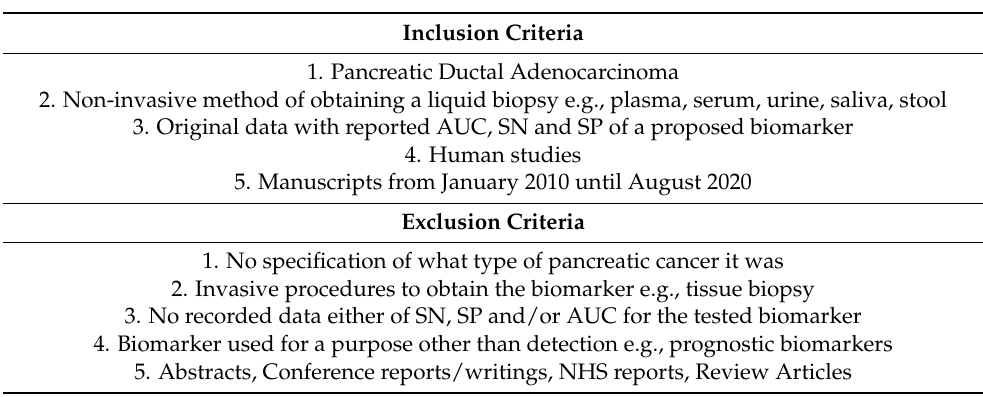
Table 1. Inclusion and Exclusion Criteria for study